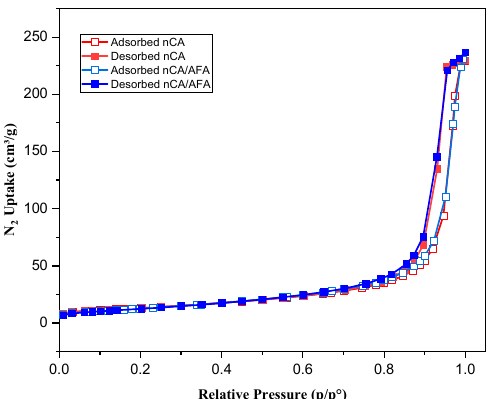
Figure 8. N 2 isotherm for nCA (red) and nCA/AFA (blue). Open and solid squares represent adsorption and desorption, respectively. Table 2. BET surface area, BJI pore size, and pore volume for nCA and nCA/AFA.